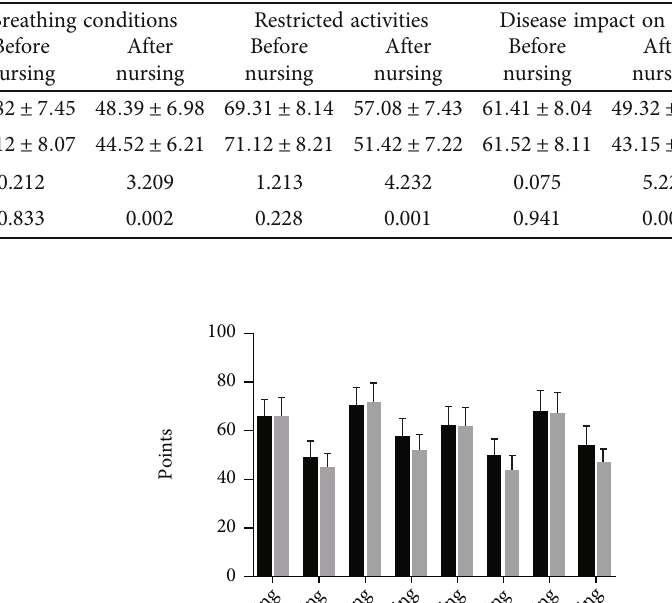
Table 5: Comparison of SGRQ scores for health impairment between the two groups [( (cid:1) x ± s ), points].